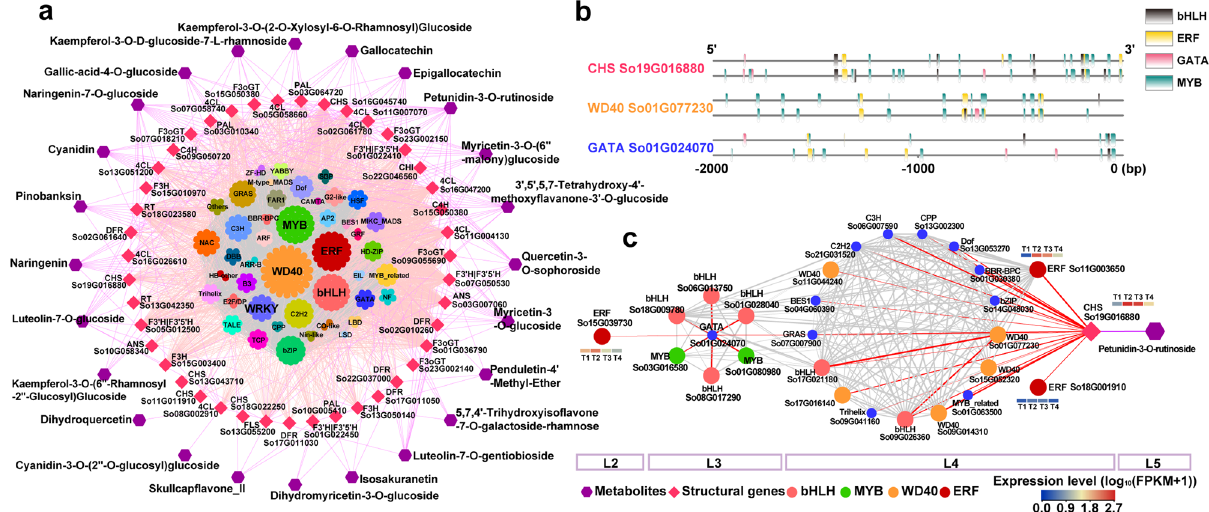
Fig. 6 Sub-network for fl avonoids metabolic pathways at the transition stage of fl owering. a Sub-network for fl avonoids metabolism. The network consists of metabolites (purple), structural genes (pink) and TFs from the outside to the inside. b DNA binding sites of the one direct regulatory gene and two potential upstream regulatory genes in 5'UTR upstream 2Kb. c Resolved one of the metabolisms of Pt3Ru and hierarchical regulation for CHS gene involved. From right to left, the network consists of metabolite (Pt3Ru in L5), structural gene ( CHS in L4), TFs that play a direct regulatory role (L4), and upstream regulatory TFs (L3 and L2). The expression pro fi les at the four fl ower opening stages were displayed as heat-maps (log 10 (FPKM + 1)). The bar color change from blue to red indicates the expression from low to high. The PCC value increases from small to large, the width of the edge changes from thinner to thicker in the